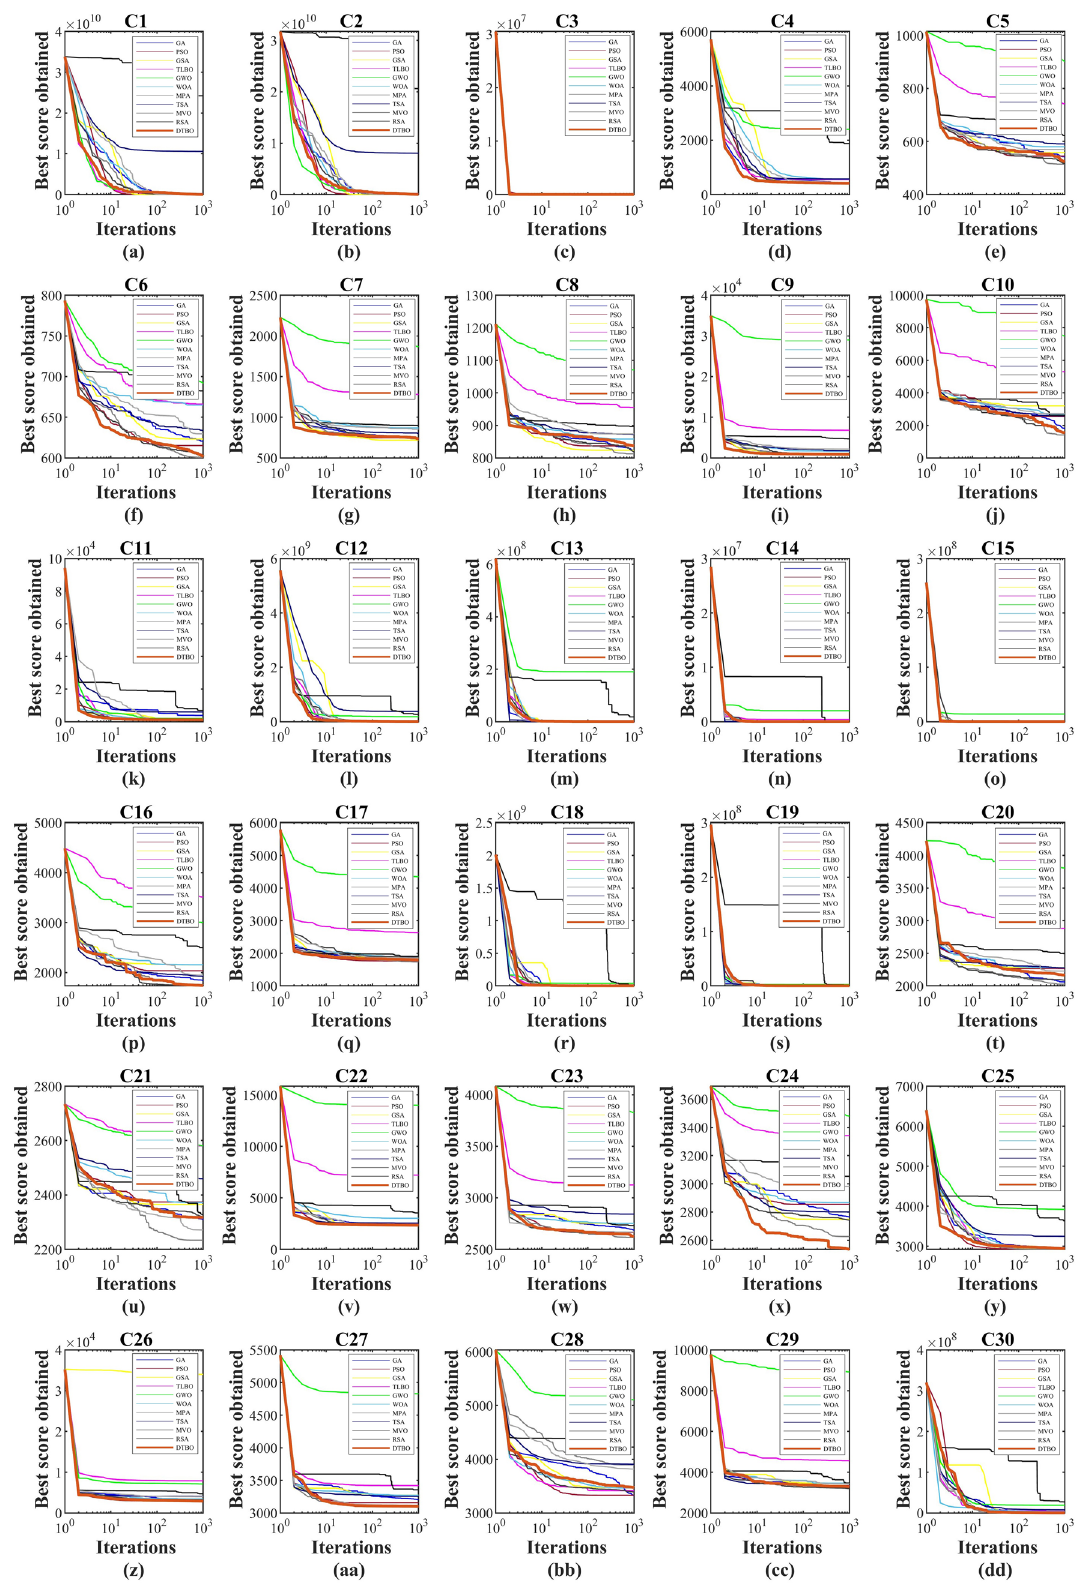
Figure 3. Convergence curves of DTBO and competitor algorithms in optimizing objective functions C 1 to C 30